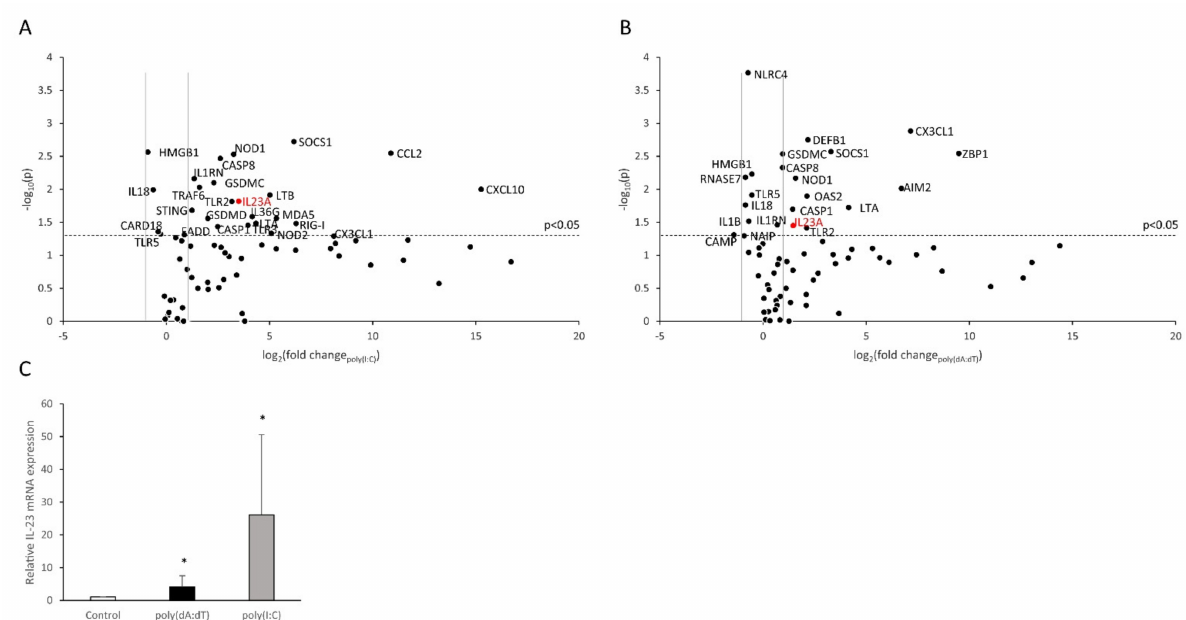
Figure 1. Changes in keratinocyte gene expression induced by poly(I:C) ( A ) and poly(dA:dT) ( B ). RT- PCR validation on independent samples revealed that NHEKs respond to poly(I:C) and poly(dA:dT) with increased IL-23 mRNA expression ( C ). To assess multiple gene expression changes upon in- flammatory stimuli, a qPCR array of inflammatory mediators and receptors was carried out on normal human epidermal keratinocyte samples transfected by 0.666 µ g/mL poly(I:C) ( A ) or 1 µ g/mL poly(dA:dT) for 12 h ( B ) and expression changes were compared to mock-transfected samples. Re- sults are presented as volcano plots, significant changes ( p < 0.05) are displayed above the horizontal dashed line. Vertical lines indicate a ± 2-fold change in expression compared to mocktransfected control samples. Four independent experiments were carried out, statistical significance was calcu- lated by Student’s t -test with correction for multiple comparisons ( A , B ). For validation, NHEKs were transfected with 0.666 µ g/mL poly(I:C) and 1 µ g/mL poly(dA:dT), samples were collected 12 h